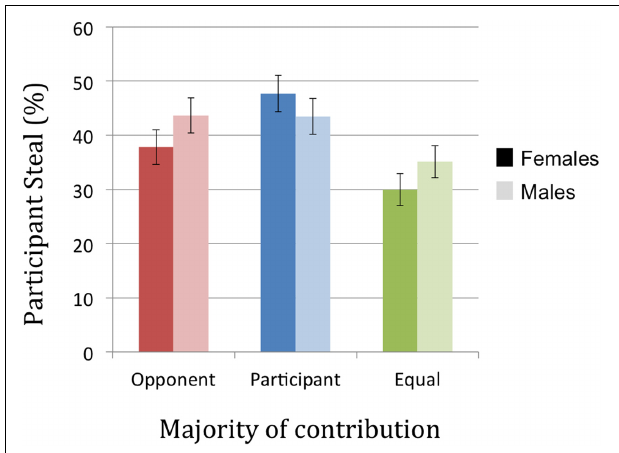
FIGURE 6 | Effect of gender and contribution on PD defect